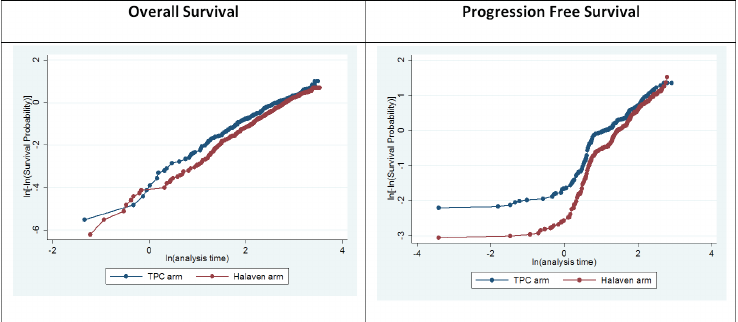
Figure 1. Log-cumulative Hazard Plots of Overall Survival and Progression-free Survival of Eribulin Mesylate and TPC